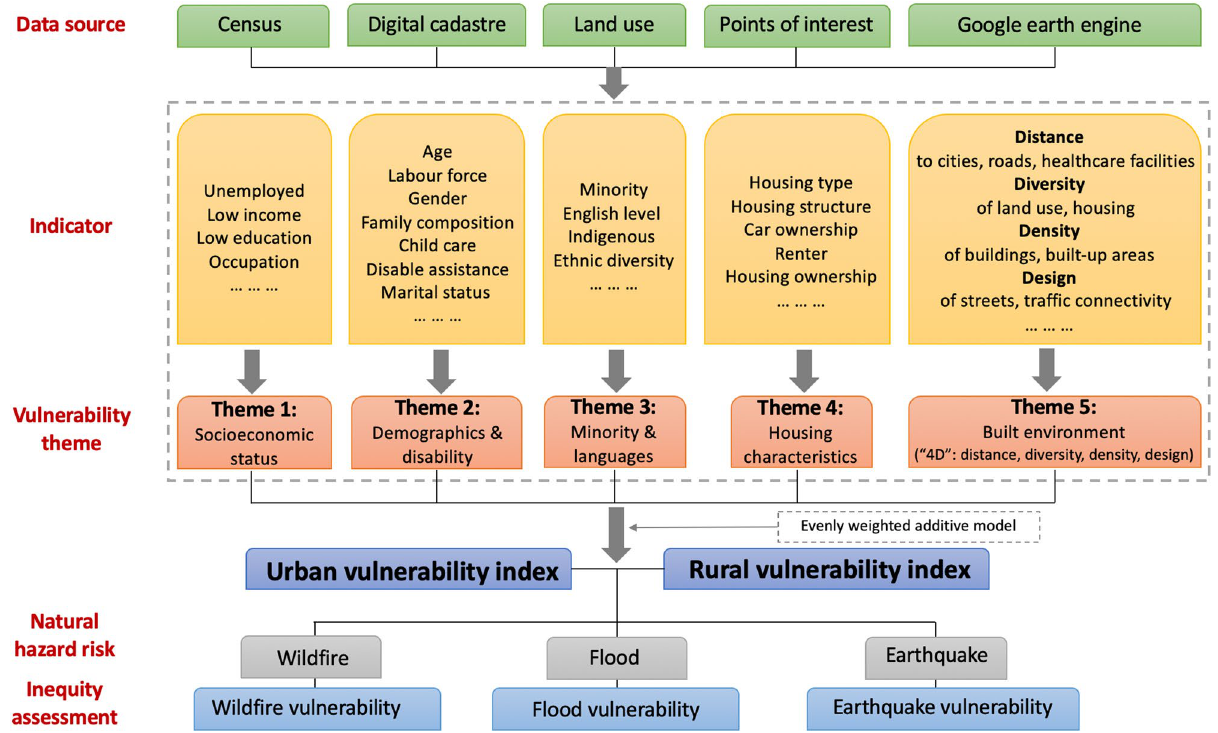
Figure 1. Research design and analytical framework. Data retrieval from the five sources and data processing are detailed in Methods. The definition and measure of each indicator with data sources are provided in Supplementary Table